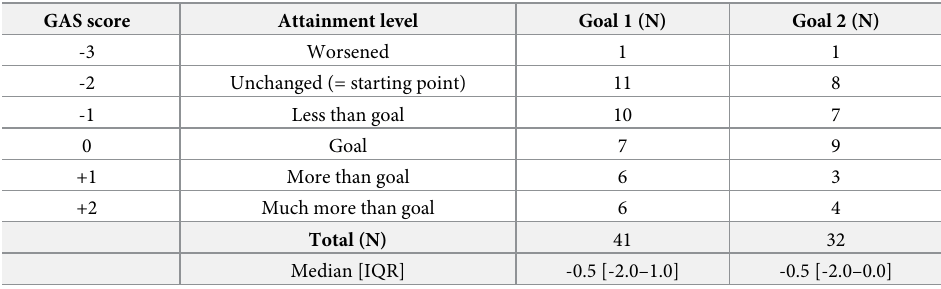
least 1 set goal is considered a clinically relevant change [41] and was achieved in 25 of 41 (61%) subjects, consisting of 3 of 8 (38%) AFO users, 13 of 19 (68%) SC-KAFO users and 9 of 14 (64%) locked KAFO users, respectively. When analysing all set goals (n = 73) classified by topic, clinically relevant improvements were achieved for 13 of 25 (52%) fatigue goals, 11 of 26 (42%) walking quality goals, 8 of 15 (53%) pain goals, 2 of 5 (40%) standing goals and 1 of 2 (50%) falling goals.